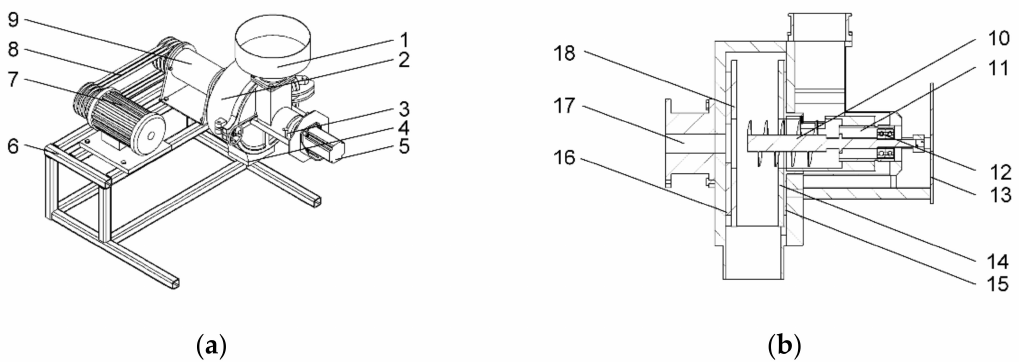
Figure 1. Schematic diagram of straw fiber crusher: 1. Feed hopper; 2. Shell; 3. Handle; 4. Speed control motor; 5. Outlet; 6. Frame; 7. Motor; 8. Belt; 9. Spindle support seat; 10. Screw feed shaft; 11. Sleeve; 12. Bearing; 13. Flange; 14. Right grinding wheel holder; 15. Right grinding wheel; 16. Left grinding wheel holder; 17. Spindle; 18. Left grinding wheel. ( a ) The whole frame; ( b ) Internal structure of the main